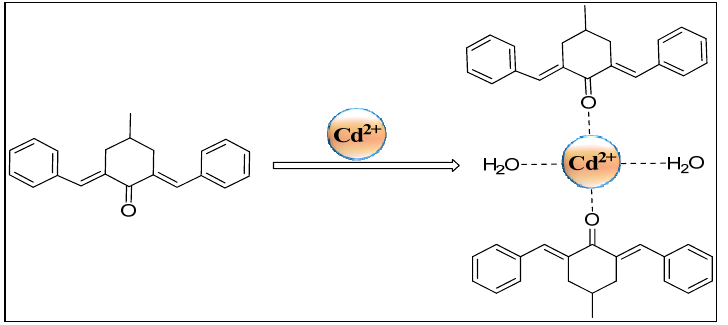
Figure 3 . Initial fl uorescence study CM1 (10 µM) and metal ions (200 µM), at λ ex = 390 nm and Figure 3. ( A ) UV-Visible absorption spectrum of chemosensor CM1 . ( B ) Fluorescence emission λ em= 610 nm . spectrum of the chemosensor CM1 when excited at 390 nm.